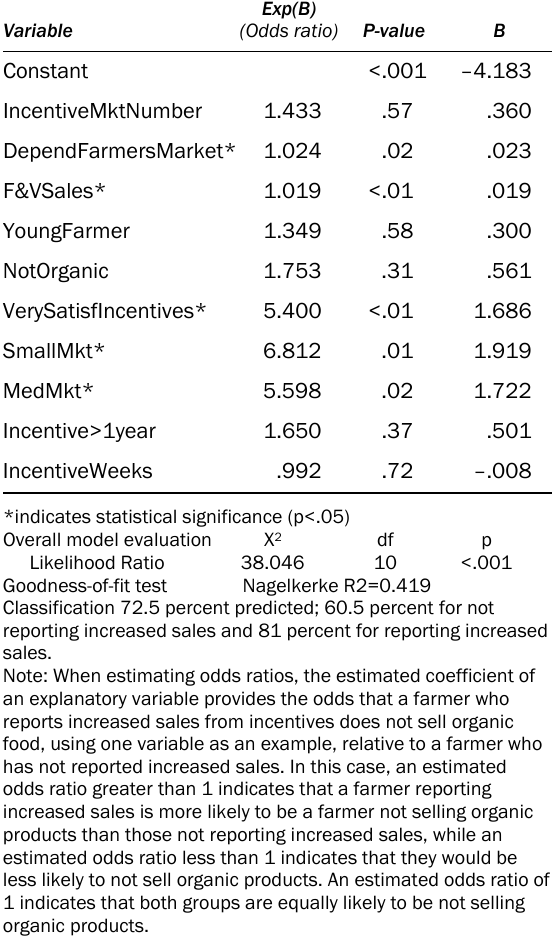
Table 5. Logistic Regression Analysis of